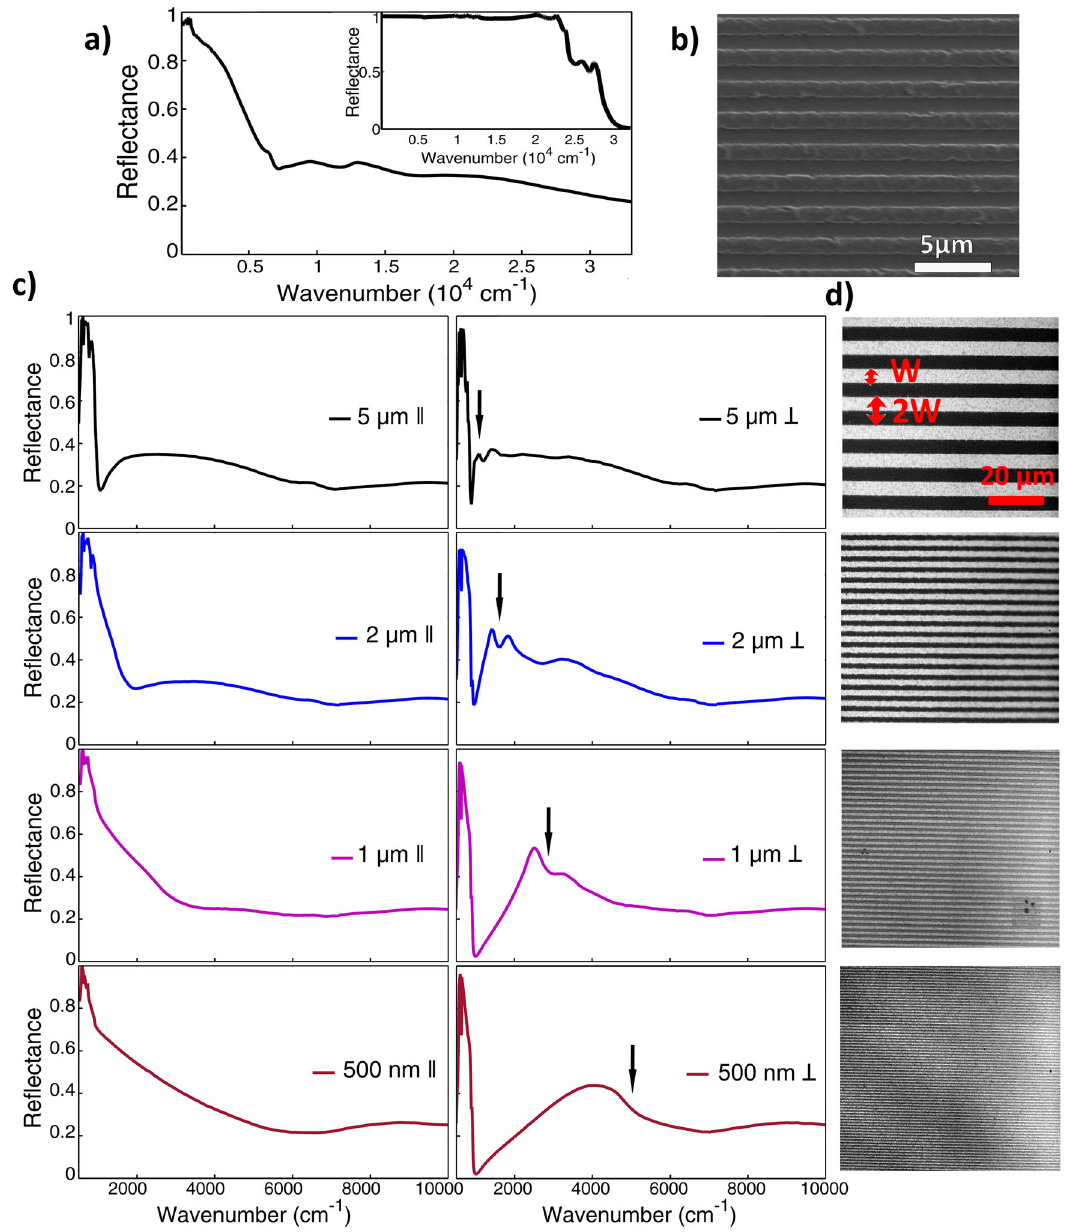
Fig. 1 Re fl ectance of unpatterned and patterned PdCoO 2 thin fi lms on sapphire. a Re fl ectance of the as-grown, unpatterned fi lm of PdCoO 2 . The inset in the right upper side shows the bare re fl ectance of PdCoO 2 extracted through RefFit program. b Scanning electron microscope (SEM) image of the W = 1 μ m patterned fi lm. The bar-size is 5 μ m. c Re fl ectance of the four patterned fi lms, with the radiation electric fi eld parallel to the ribbons (left column) and perpendicular to the ribbons (right column). Arrows indicate approximately the frequency location of surface plasmon excitations. d Optical microscope images of the four patterned fi lms with different widths W and periods 2W. All the images have the same dimensions. Brighter parts are related to the oxide fi lm, while darker regions are associated to the sapphire